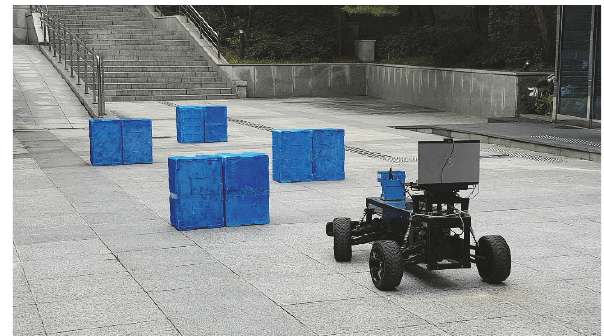
Figure 16: Outdoor experimental